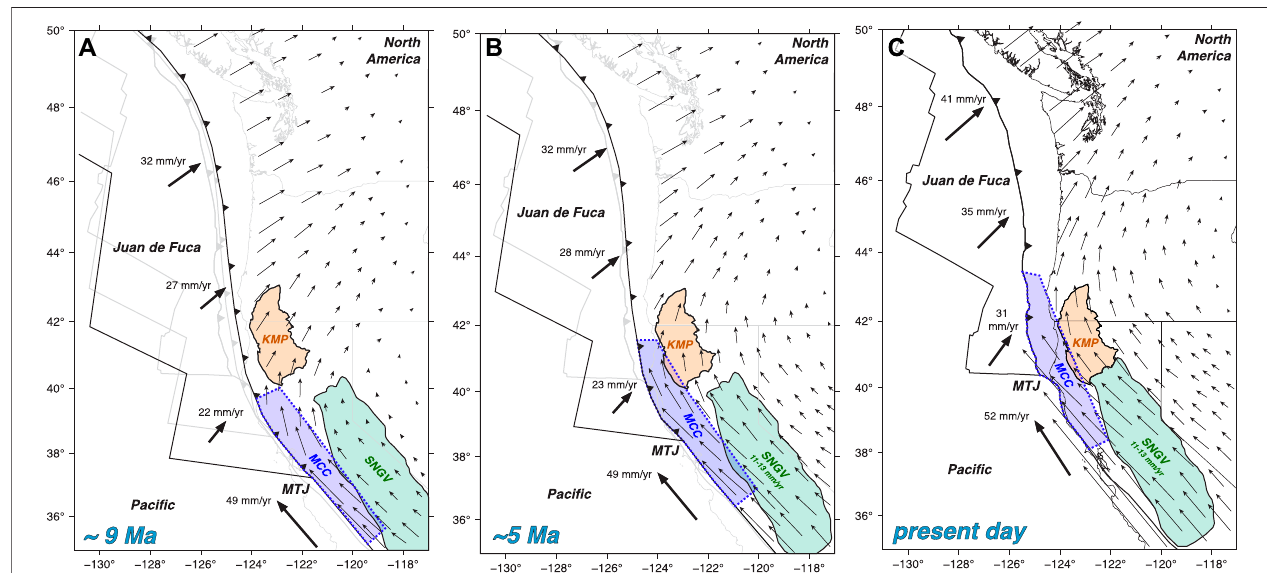
FIGURE 4 | Plate reconstructions showing the total (subduction plus NNW-directed processes) synthetic GPS velocities for the region from 9 Ma to present-day. The KMP is outlined and shaded in orange, the Sierra Nevada/Great Valley (SNGV) block is outlined and shaded in green, and the approximate spatial extend of deformation(thickeningandthinning)associatedwiththeMCCisoutlinedandshaded inblue. (A) ~9 Ma, (B) ~5 Ma, (C) present-day.Reconstructionsweredoneusing the SNGV-North America Euler stage pole (d ’ Alessio et al., 2005), Paci fi c – Juan de Fuca Euler poles (Wilson, 1993) and Paci fi c-North America Euler poles (DeMets and Merkouriev,